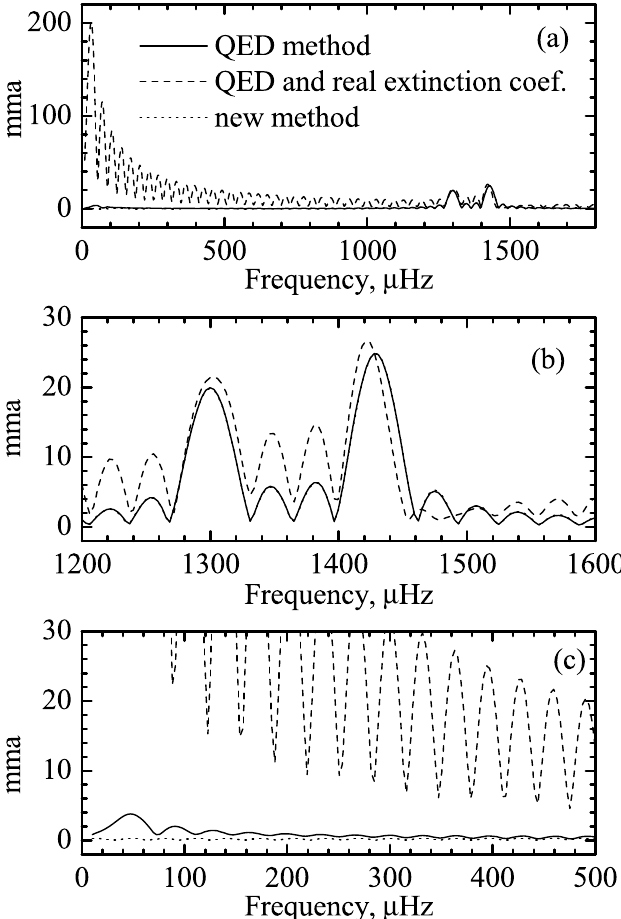
Fig. 10. FT for synthetic observations when the extinction is constant all the time, but the extinction correction methods are different: (a) – for frequencies between 0 and 1800 μ Hz; (b) – for frequencies between 1200 and 1600 μ Hz; (c) – for frequencies between 0 and 500 μ Hz. The power spectra after use of the QED method and of the new method are close and overlap at higher